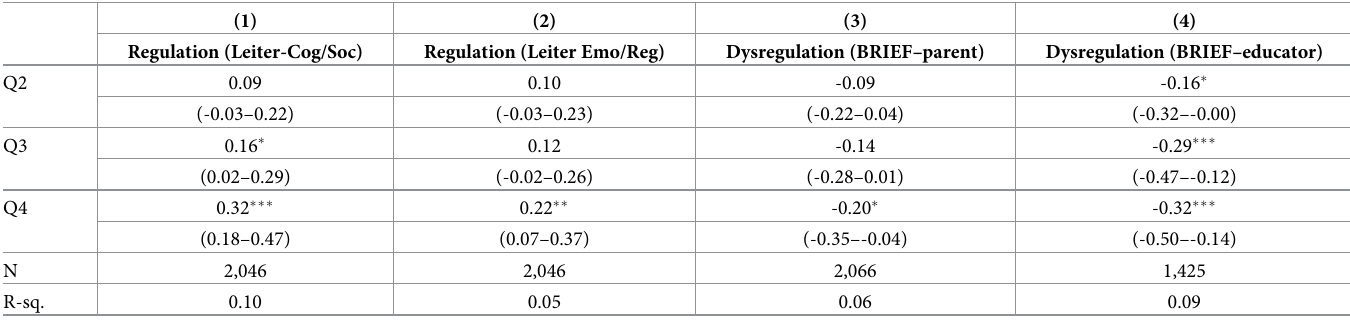
Table 4. Average SES effects in self-regulation skills.